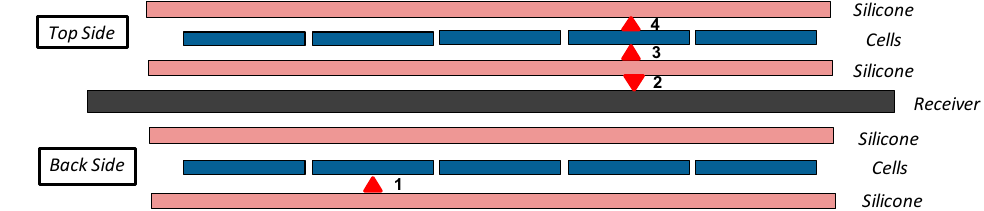
Figure 9. The placement of each temperature sensor on the different layers of the receiver.